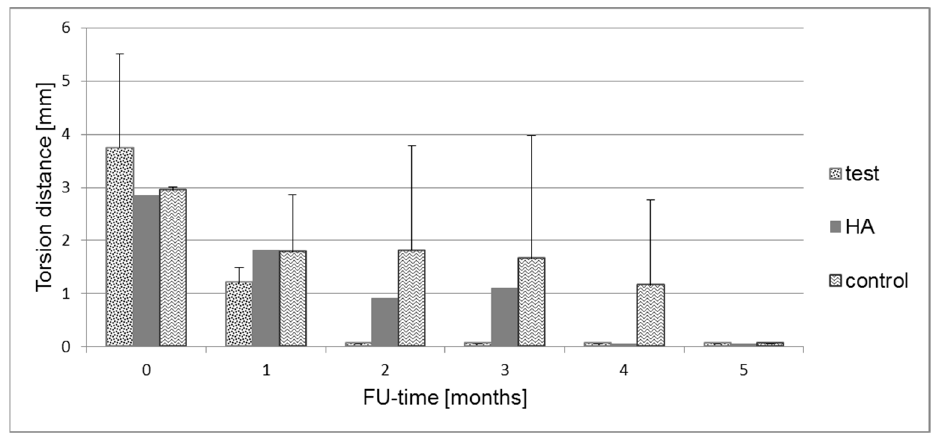
Figure 3. Biomechanical measurement showing the respective torsion distance until the torsion force of 20 N was